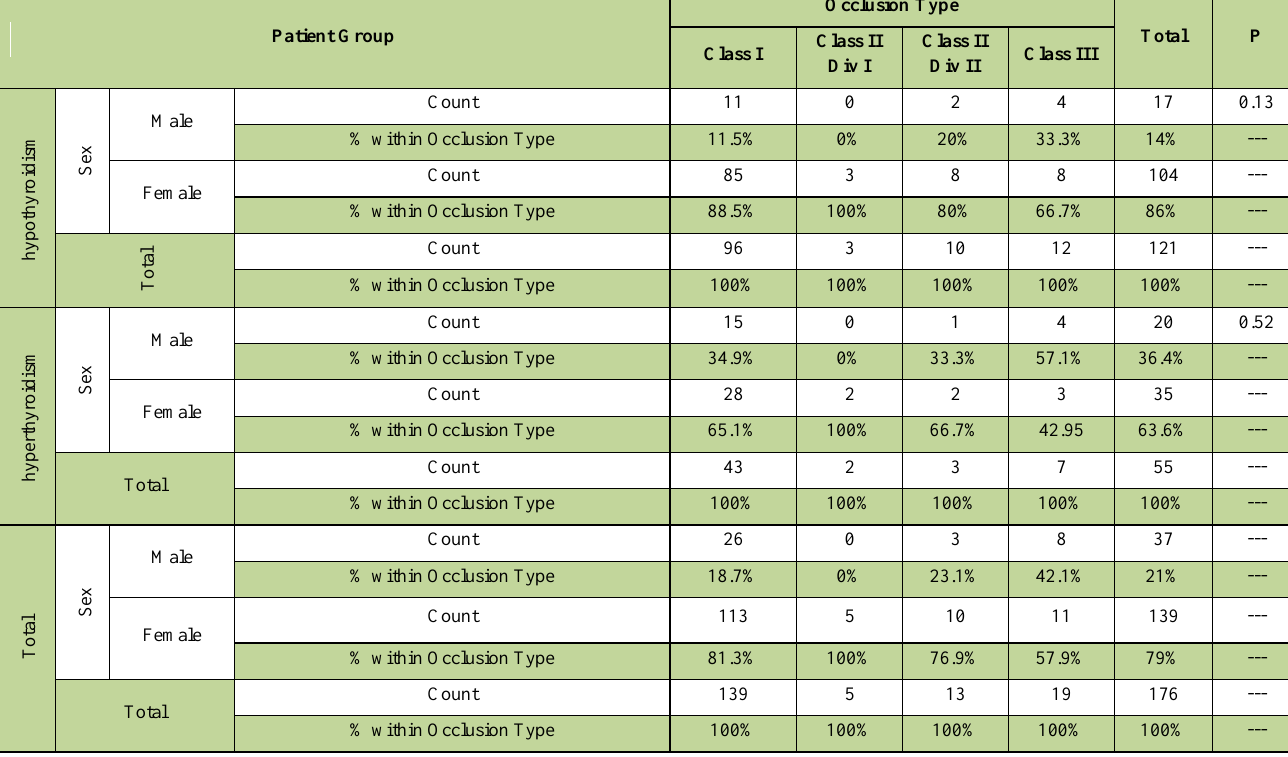
Table 10. Frequency of malocclusion in two groups of patients by